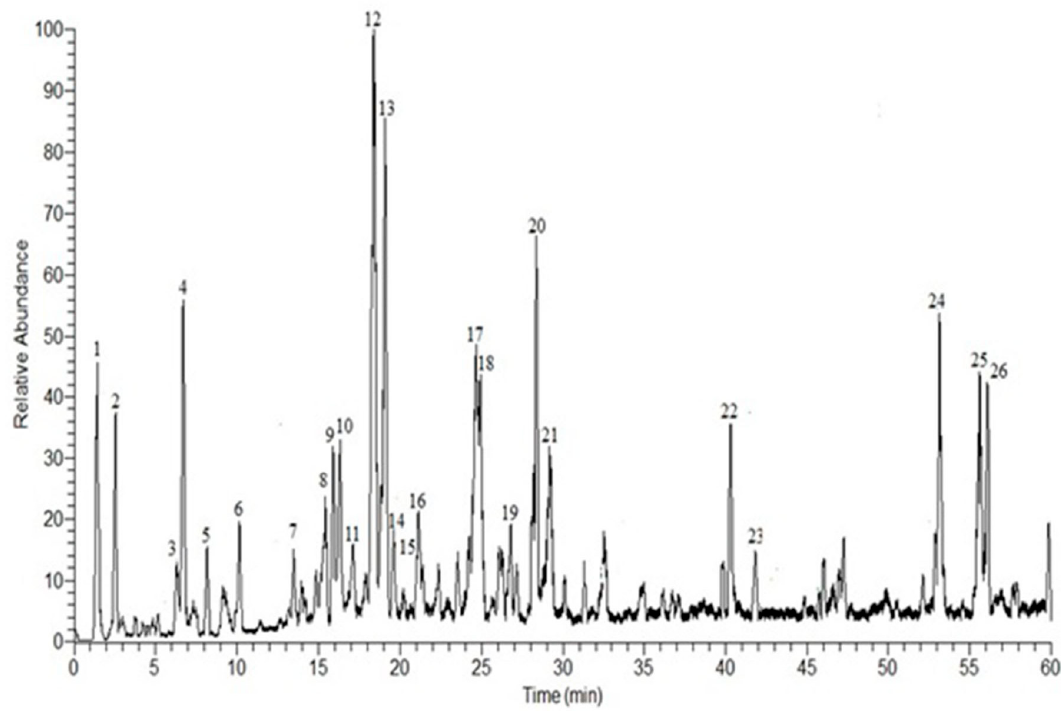
Figure 1. Negative HPLC-DAD-ESI-MS / MS profile of phenolic compounds from the methanol extract of E. globulus leaves. Peak numbers agree with those in Table 1.